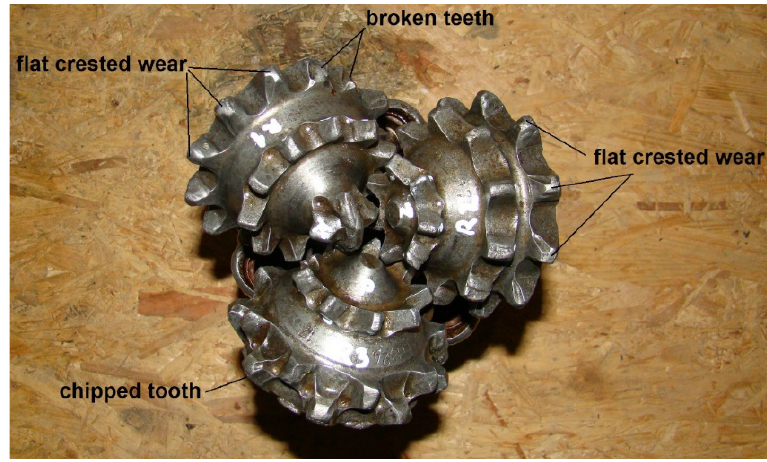
Figure 15. Characteristic dull of the roller cone bit.